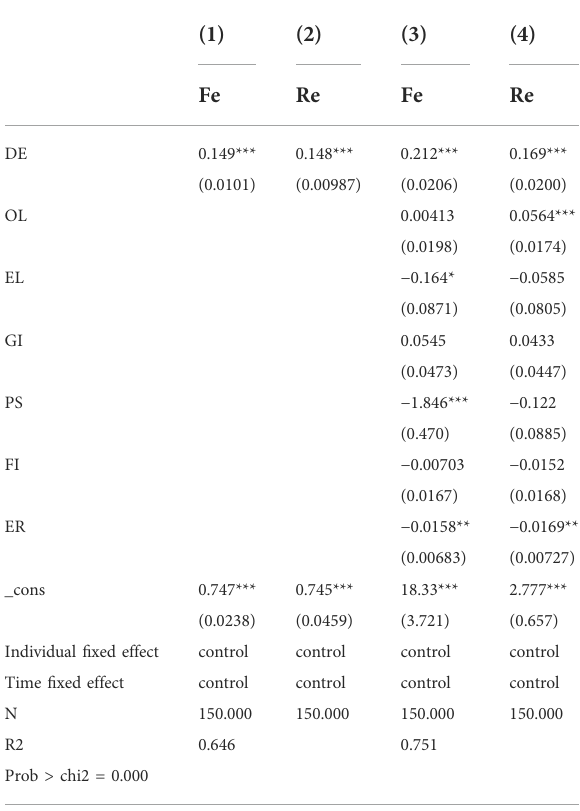
TABLE 4 Benchmark regression results. TABLE 5 Regional heterogeneity